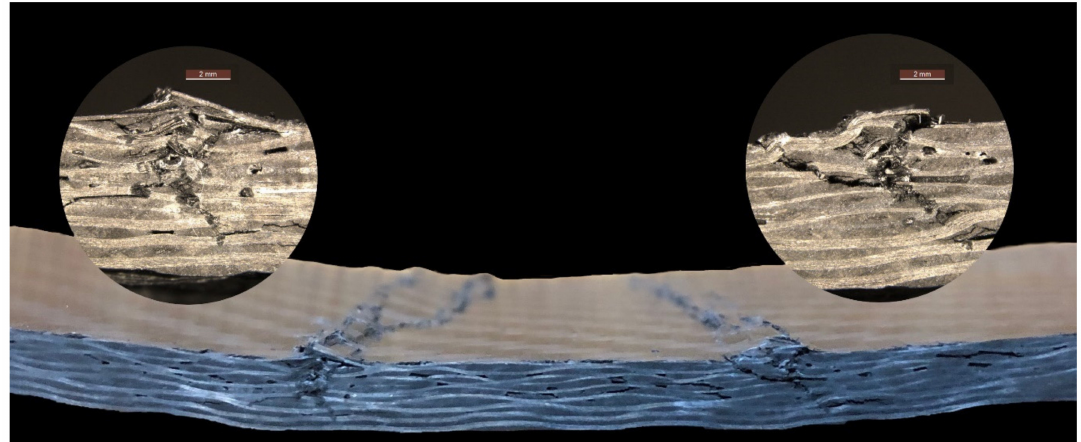
Figure 3. Experimental and numerical results of the four-point bending tests.